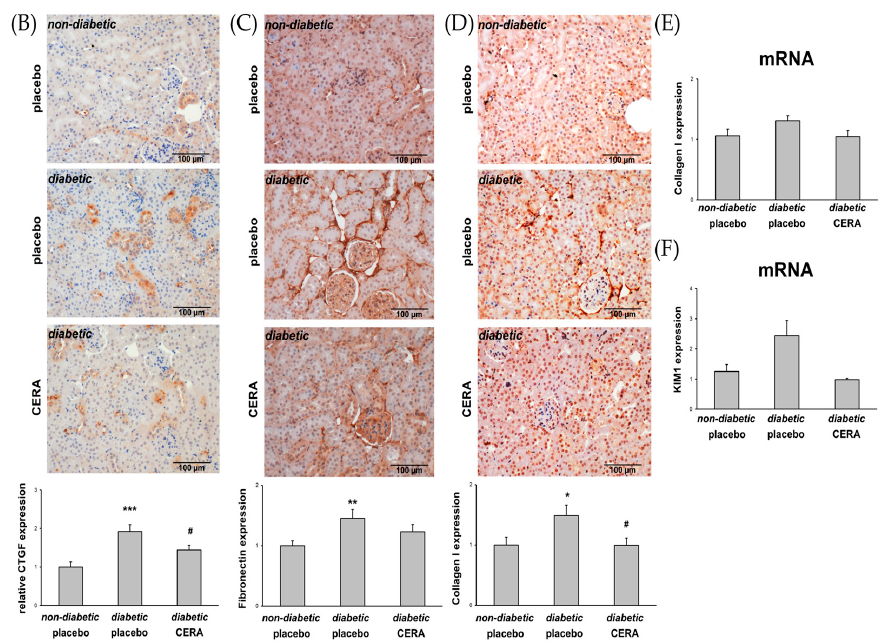
Figure 1. The tubulointerstitial fibrosis is reduced by CERA in diabetic kidneys. ( A ) Picrosirius red. Representative images of picrosirius red staining (magnification: 200 × ). Left: bright field illumination. Right: polarization contrast illumination. The color of the fibers shows the collagen content (increasing thickness: from green to yellow to orange to red); ( B ) CTGF. Representative images of CTGF immunohistochemistry (magnification: 200×) and semi-quantitative analysis of the staining (graph); ( C ) Fibronectin. Representative images of fibronectin immunohistochemistry (magnification: 200×) and semi-quantitative analysis of the staining (graph); ( D ) Collagen I. Representative images of collagen type I immunohistochemistry (magnification: 200×) and semi-quantitative analysis of the staining (graph); ( E ) Collagen I mRNA. Real-time PCR analysis of the renal collagen I mRNA expression. Values were normalized to the expression of housekeeping genes; ( F ) KIM1 mRNA. Real-time PCR analysis of the renal KIM1 mRNA expression. Values were normalized to the expression of housekeeping genes. Whereas placebo-treated diabetic animals show significant increase in all tested fibrosis marker, compared to non-diabetic controls, CERA treatment reveals anti-fibrotic effects in kidneys of diabetic mice. * p ≤ 0.05, ** p ≤ 0.01, *** p ≤ 0.001 = diabetic vs. non-diabetic control; # p ≤ 0.05 = db / db CERA vs. db / db placebo. The non-diabetic controls